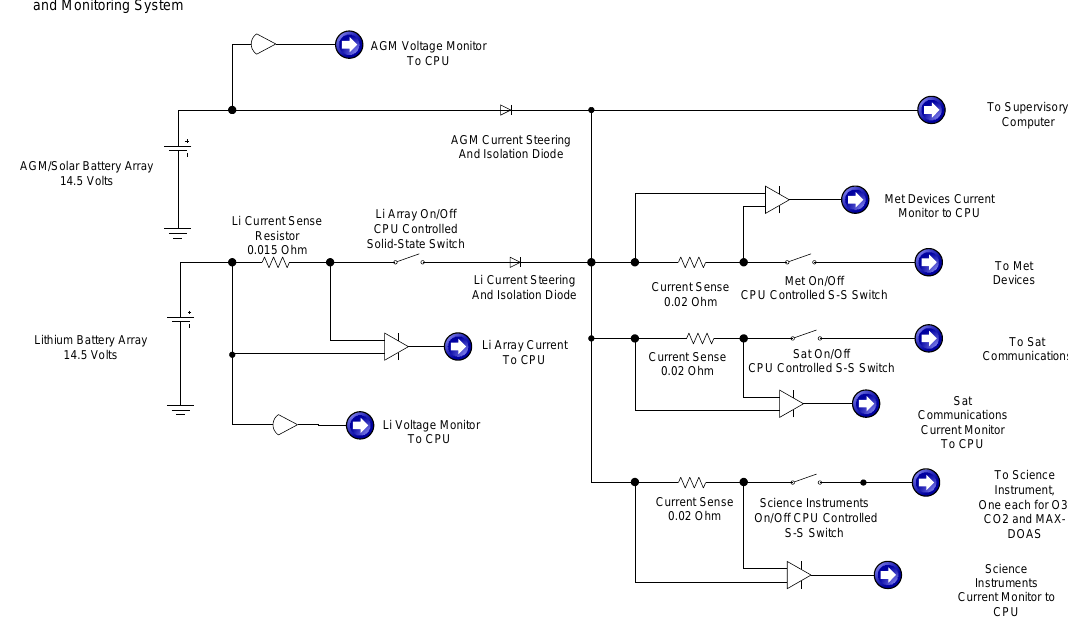
Fig. 5. Schematic representation of the power control board used on the buoy. For a full diagram see supplementary material (http://www.